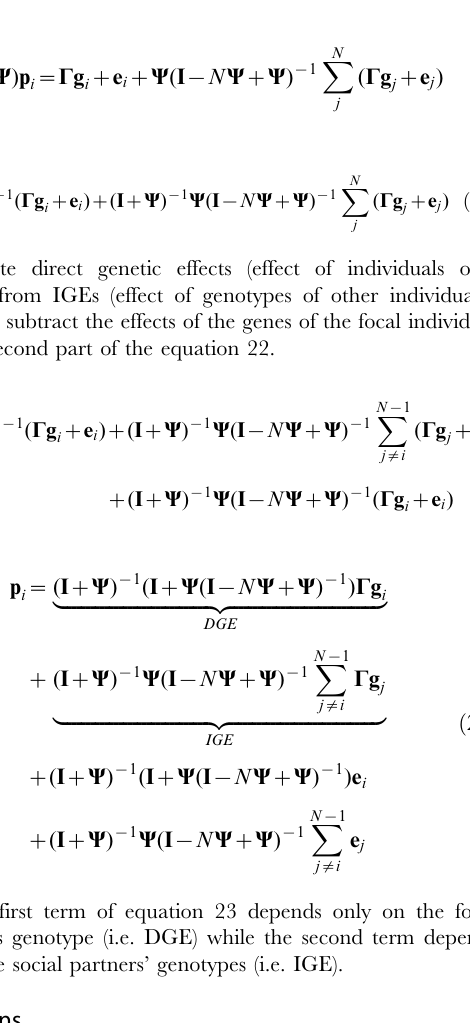
Table 1. Populating of matrix Y for given interactions.